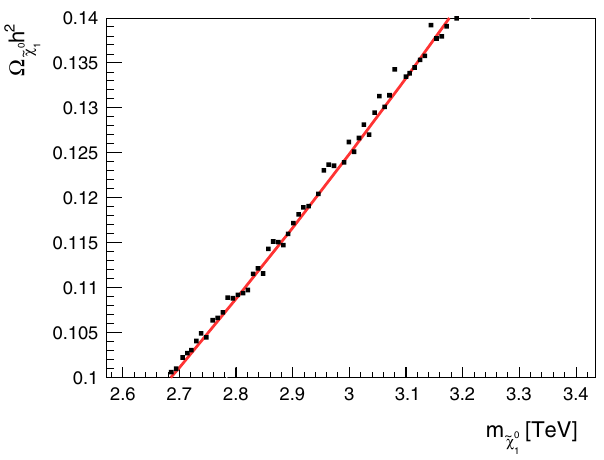
h 2 comparing results from SSARD and our dots ) with our Sommerfeld implementation ( red line ), and the right Fig. 1 Calculations of (cid:4) ˜ χ 0 1 panel shows the ratio of the calculated relic densities, connecting the simplifiedtreatmentoftheSommerfeldenhancementinthecaseofwino points in the left panel by a continuous blue dark matter. The left panel compares the SSARD calculations ( black